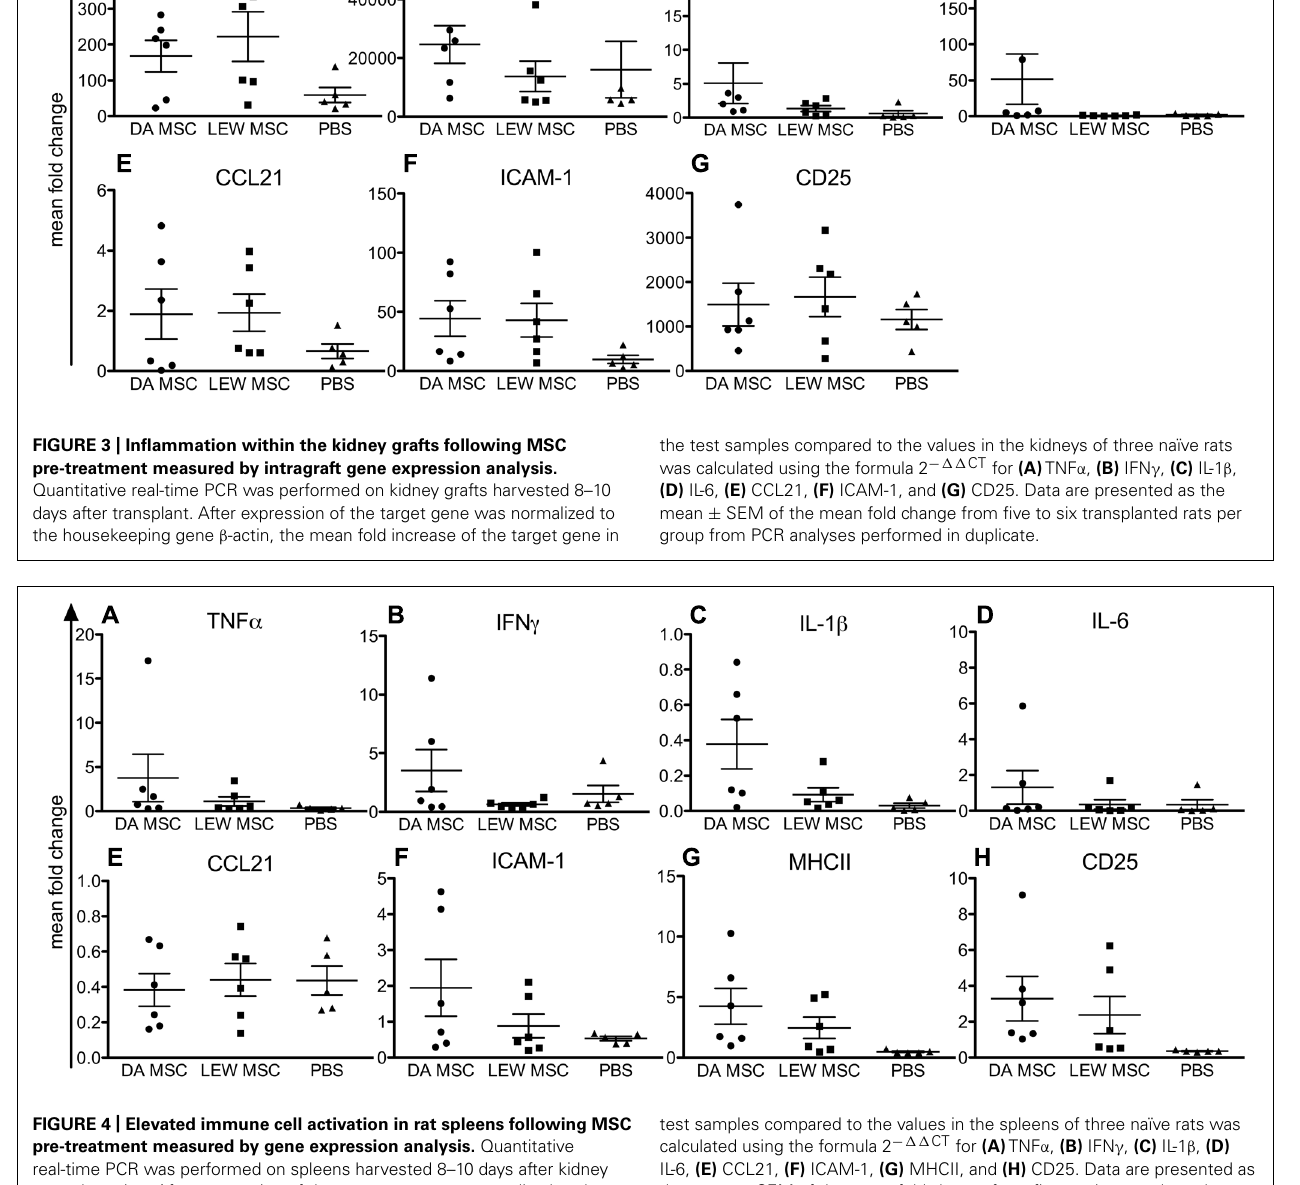
test samples compared to the values in the spleens of three naïve rats was calculated using the formula 2 − (cid:2)(cid:2) CT for (A) TNF α , (B) IFN γ , (C) IL-1 β , (D) IL-6, (E) CCL21, (F) ICAM-1, (G) MHCII, and (H) CD25. Data are presented as the mean ± SEM of the mean fold change from five to six transplanted rats per group from PCR analyses performed in